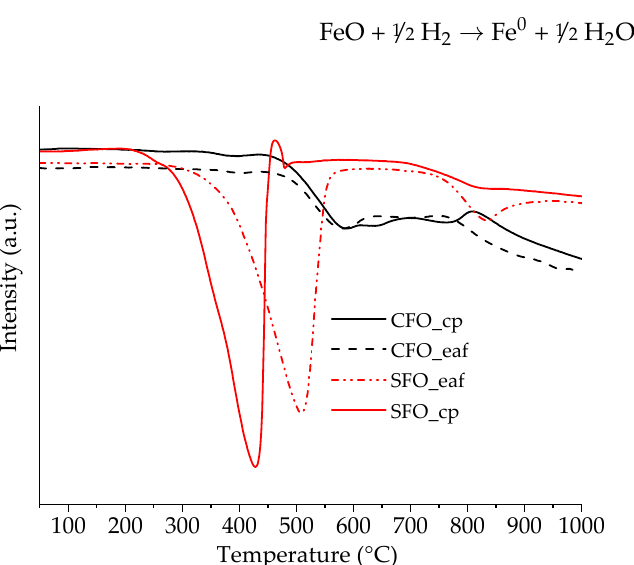
Figure 3. H 2 -temperature-programmed reduction of CFO_cp, CFO_eaf, SFO_cp and SFO_eaf.